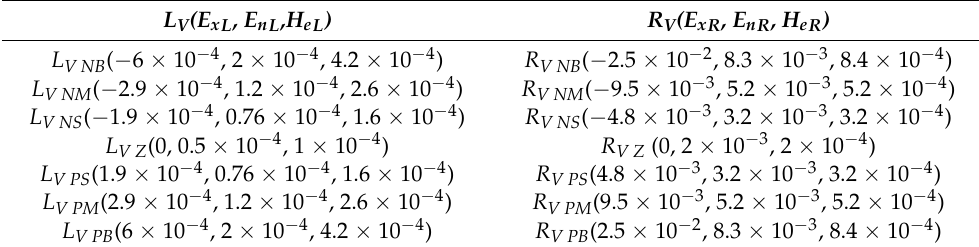
Table 5. Digital characteristics for output signals.